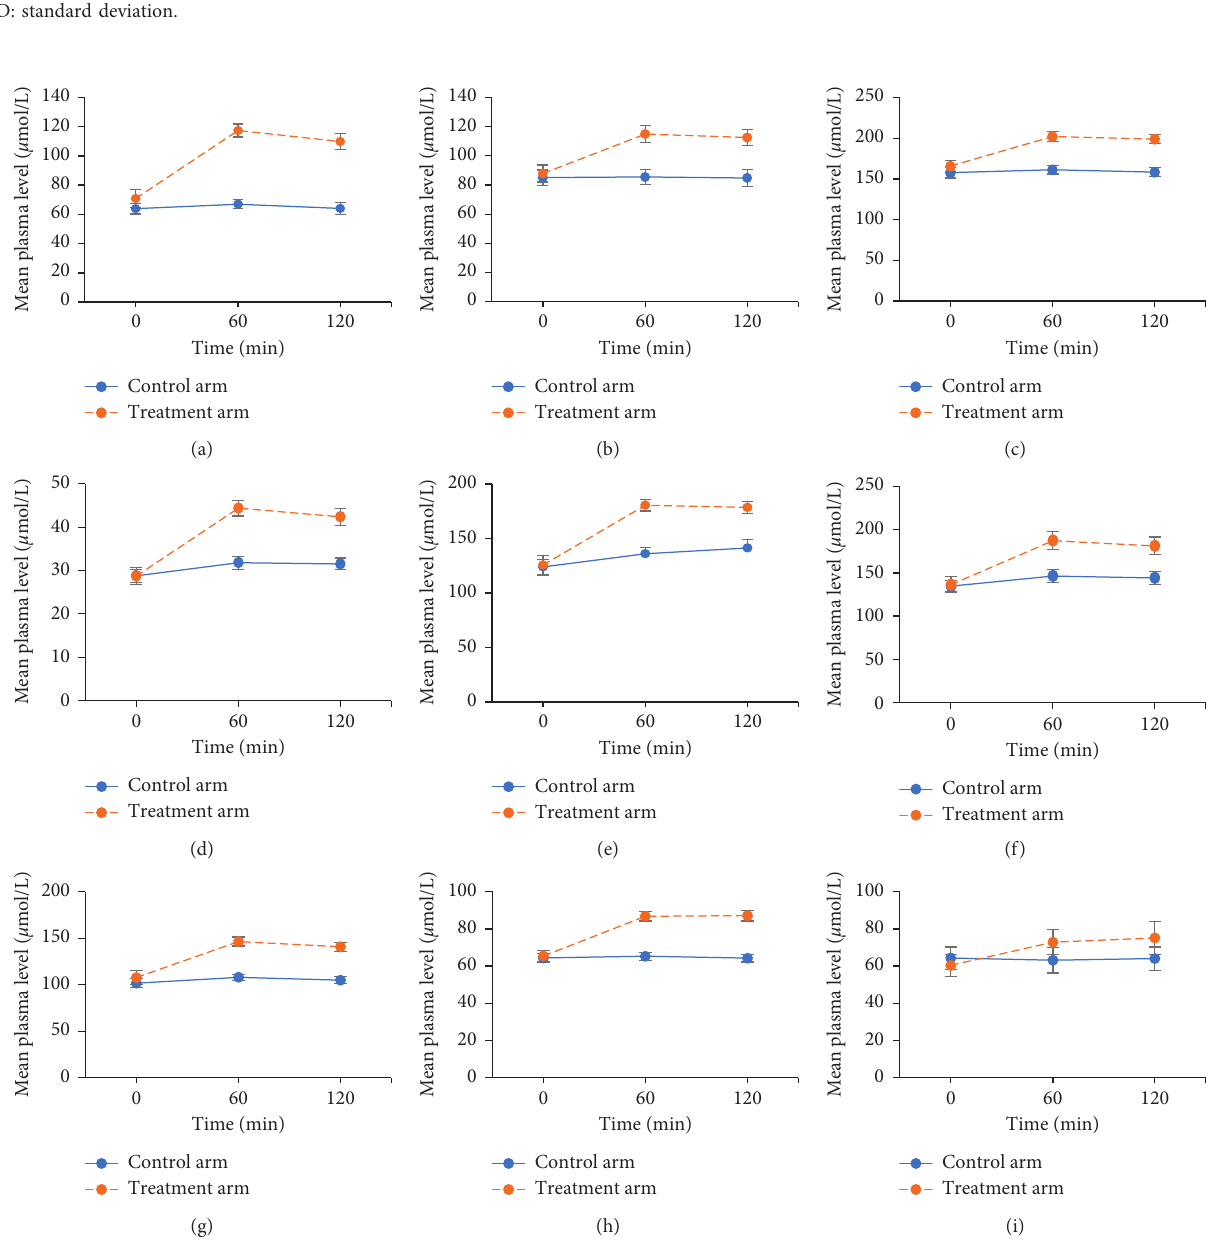
Figure 2: Changes in plasma levels of essential amino acids with time in the treatment and control arms. (a–c) Branched-chain amino acids. (d–i) Other essential amino acids. (a) Isoleucine. (b) Leucine. (c) Valine. (d) Methionine. (e) Lysine. (f) Threonine. (g) Tryptophan. (h) Phenylalanine. (i) Histidine.